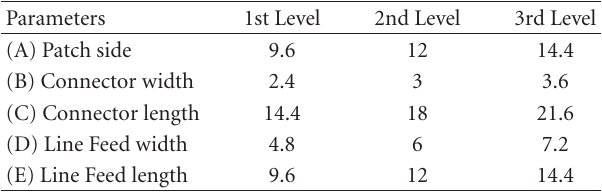
Table 1: The initial levels for the optimization procedure. Parameters